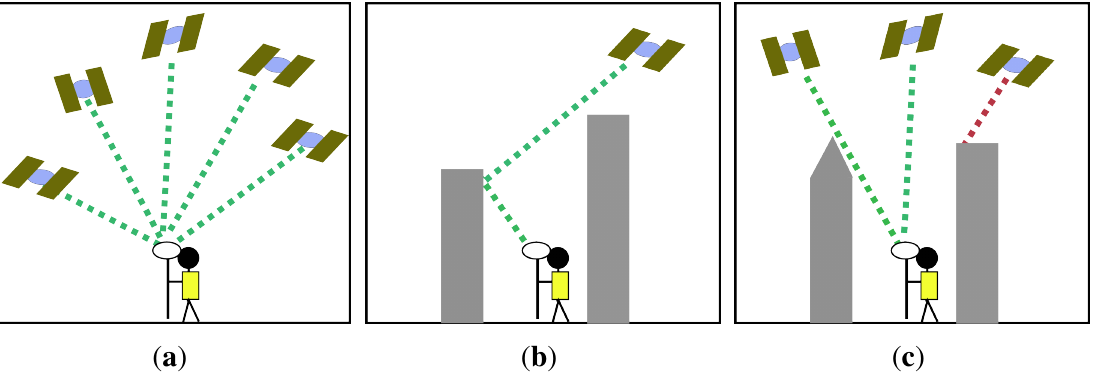
Figure 11. Possible error sources in GNSS predictions and validation ( a ) the goal is LOS to five satellites ( b ) multipath resulting in errors in validation results ( c ) a discrepancy between LOD2 models which better approximate real world objects and LOD1 models which ignore roof structure created with 2D vector